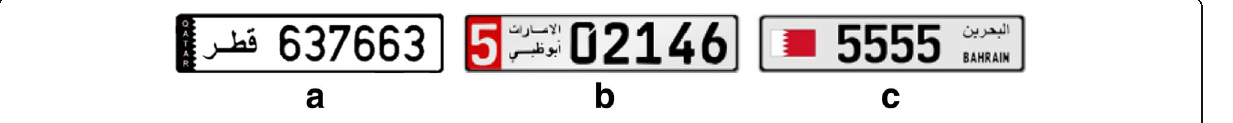
Fig. 1 NPs of a Qatar, b UAE, and c Kingdom of